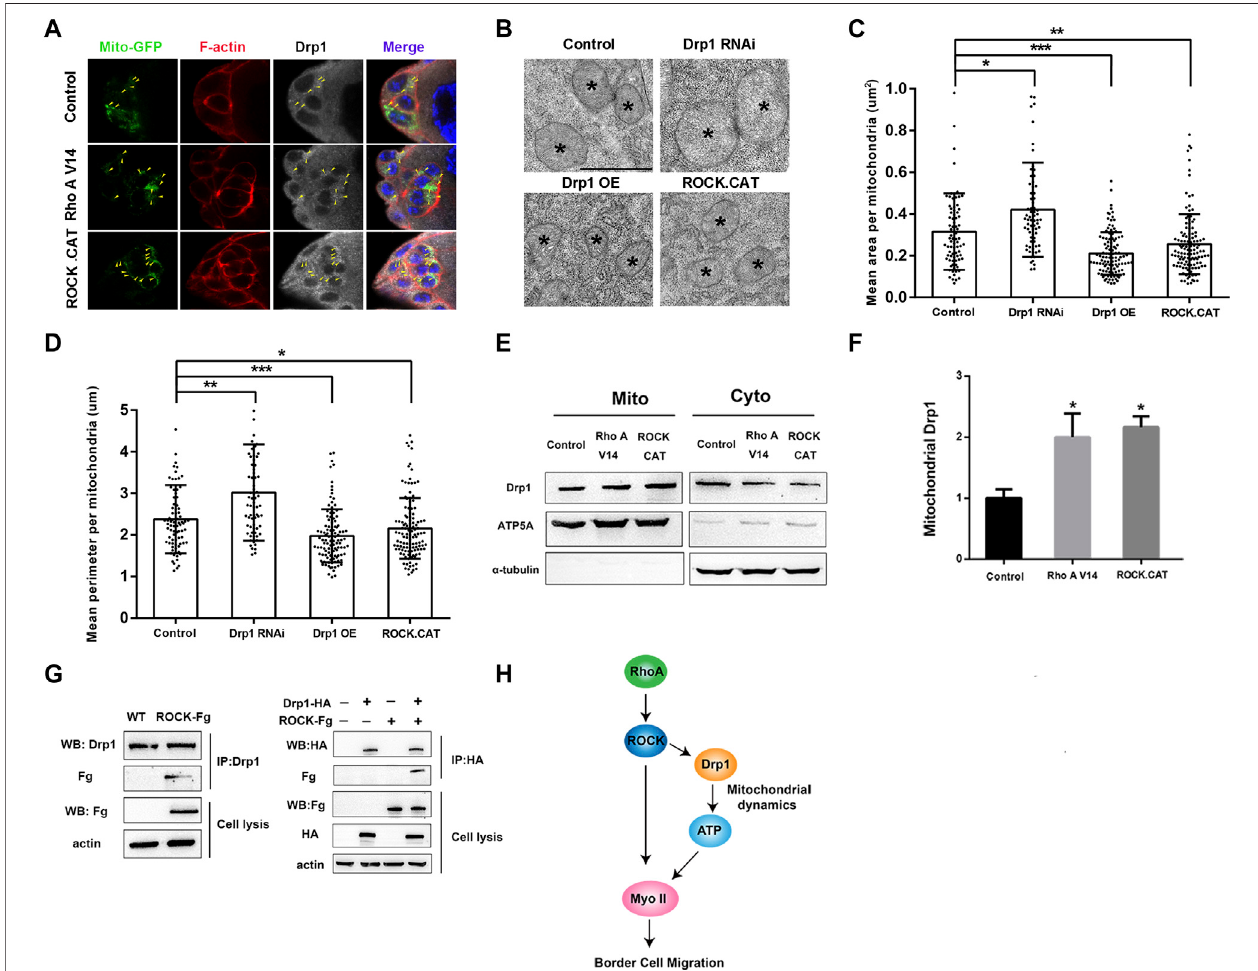
FIGURE 4 | RhoA/ROCK signaling induces mitochondrial fi ssion through interacting with Drp1. (A) Confocal images of early stage 9 border cell clusters stained with Mito-GFP (for mitochondria), phalloidin (for F-actin), Drp1 antibody and DAPI (for nuclei) with indicated genotypes. The colocalization of mitochondria and Drp1 is indicated by the yellow arrowhead. Expression of RhoA V14 or ROCK.CAT leads to defects of rounded border cells and migration delay, as has previously been described (Bastock and Strutt, 2007), and the cell rounding is likely due to excessive contractile activity in the cortical actomyosin network as resulted from overactivation of Myosin II. (B – D) TEM analysis was performed for the follicle cells of stage 9 or 10 egg chambers with indicated genotypes. Mean area (C) and mean perimeter (D) per mitochondria were calculated and used as two indicators of mitochondrial size and morphology. Mean area and mean perimeter were measured by ImageJ.The mitochondria arefrom differenteggchamberswithindicated genotypes ( n =81,63,109and 119fromleft toright),respectively.However, duetothesmall size and the dif fi culty to locate border cell cluster within egg chambers, we were unable to obtain TEM images of the border cells. (E,F) Expressing RhoA V14 or ROCK.CAT inthefolliclecellsbythe GR1-Gal4 driverincreasedlevelsofmitochondria-associatedDrp1intheovaries.Thewholeproteinsfromovarieswereanalyzedby Western blot with ATP5A and α -tubulin as mitochondrial and cytosolic markers respectively. (G) co-immunoprecipitation (co-IP) was performed using the newly generated antibody against Drosophila Drp1 (see Supplementary Figure S7 for methods and details). The endogenous Drp1 could be co-immunoprecipitated together with the exogenous ROCK-Fg, indicating that Drp1 binds to ROCK-Fg in S2 cells. Western blot of immunoprecipitates of Drp1-HA from S2 cells indicates that exogenously expressed Drp1-HA also physically interacts with ROCK-Fg in S2 cells. (H) A model showing Rho A/ROCK signaling in migratory border cells promoting Myosin II activity and dynamics by simultaneously regulating Drp1-mediated mitochondrial fi ssion and direct phosphorylation of Myosin II (see Discussion for details). Scale bars: 10 μ m in (A) , 1 μ m in (B) . Error bars indicate SD * p < 0.05, ** p < 0.01, *** p < 0.001, n.s., not signi fi